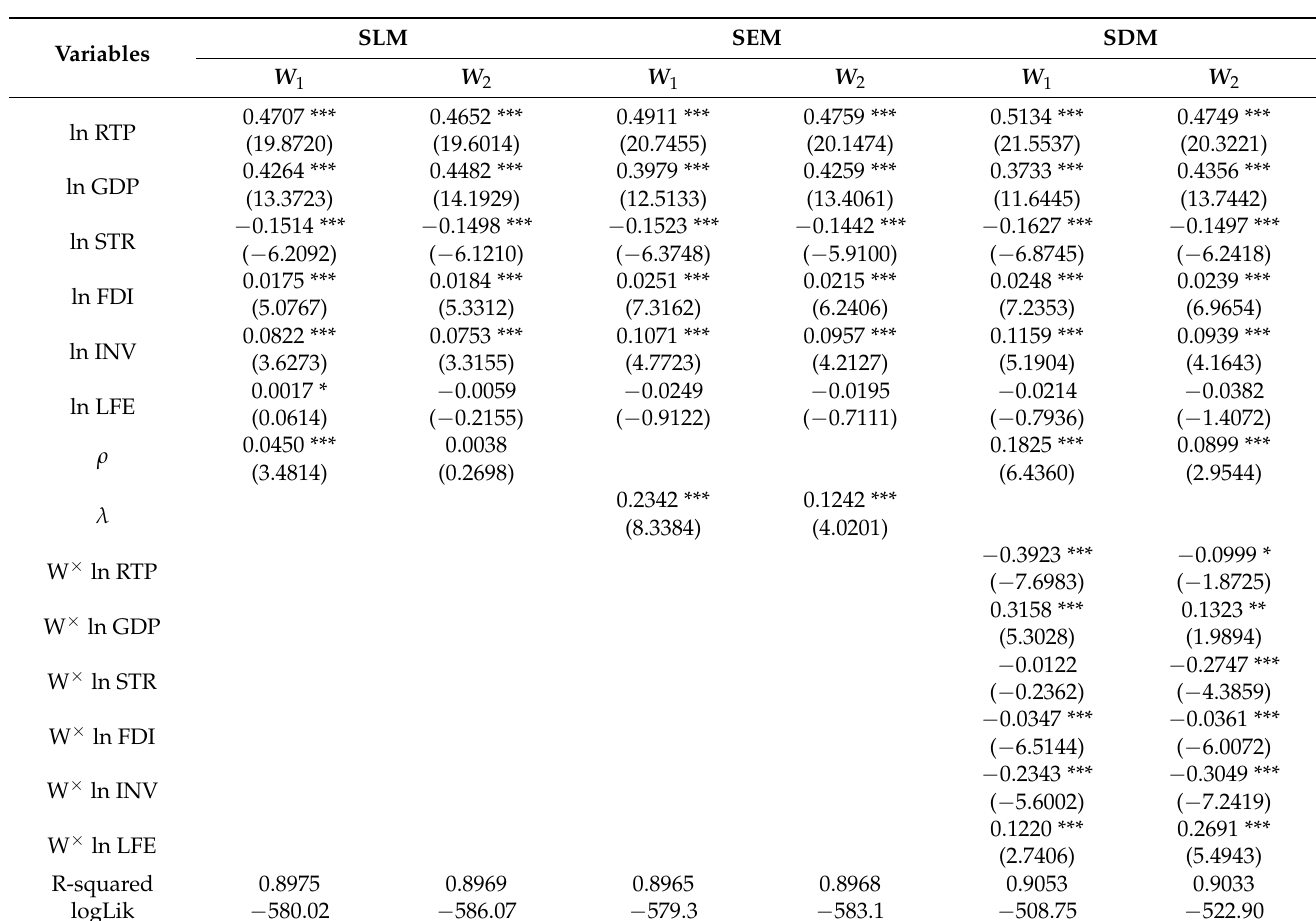
Table 8. Regression results of SLM, SEM, and